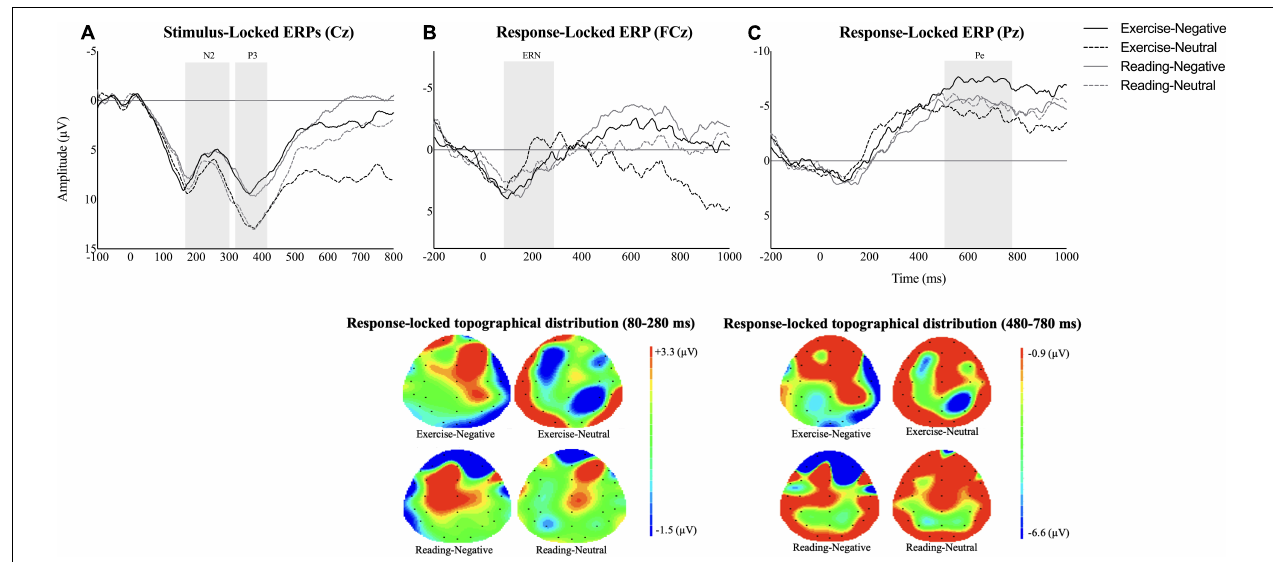
FIGURE 3 | Average waveforms across interventional sessions and emotional conditions for (A) stimulus-locked event-related potentials (ERPs) at Cz (N2: 170–300 ms; P3: 310–410 ms), (B) error-related negativity (ERN) at FCz (80–280 ms), and (C) Pe at Pz (480–780 ms). The additional scalp topographies are also provided to depict the response-locked activities within time widows of 80–280 ms and 480–780 ms across